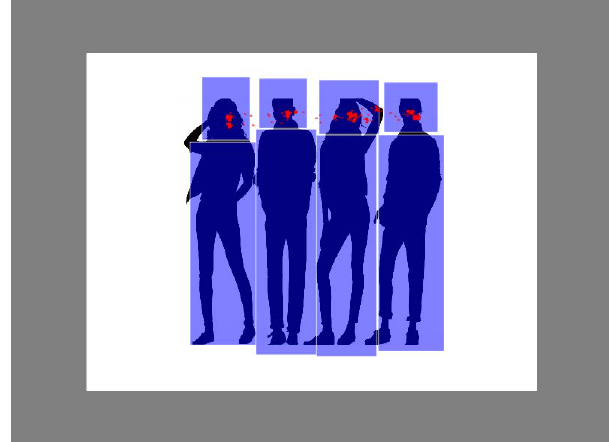
Figure 3. An example of eye-movement data (red dots) recorded from a Swedish participant. Areas of interests (AOIs) are represented by the blue